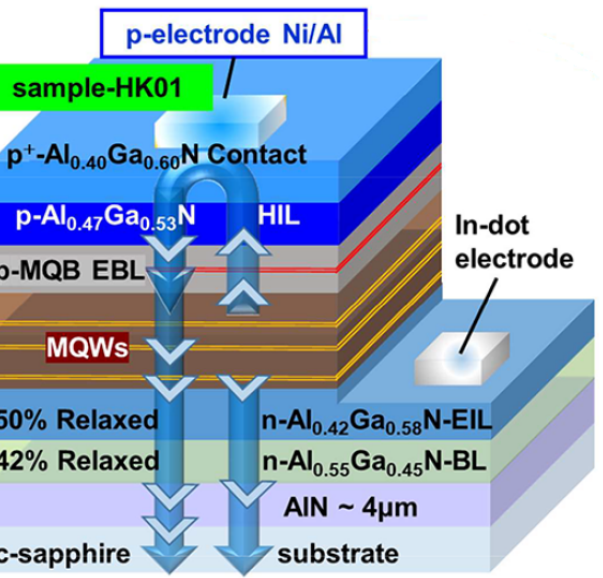
Figure 4. Schematic view of EIL-based 310 nm band UVB LEDs based on highly reflective Ni/Al p-electrode. [16] Copyright 2020, ACS Publishing.